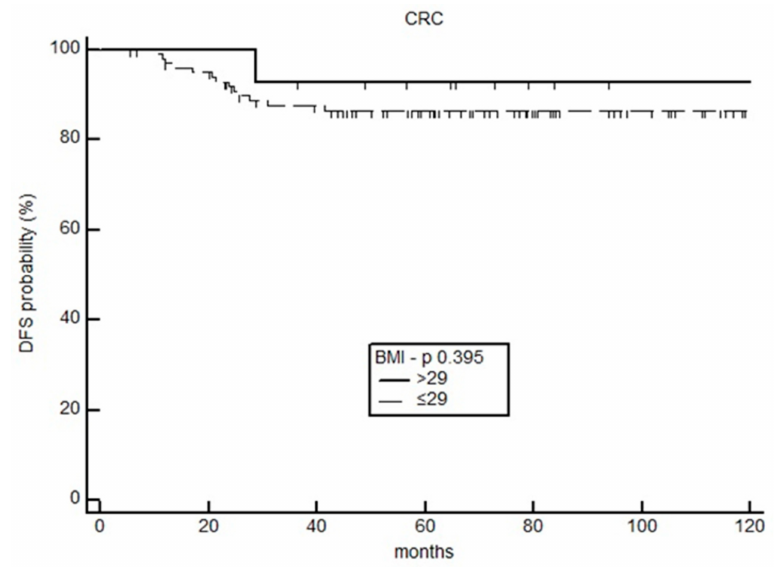
Figure 6. Disease-free survival in CRC patients.